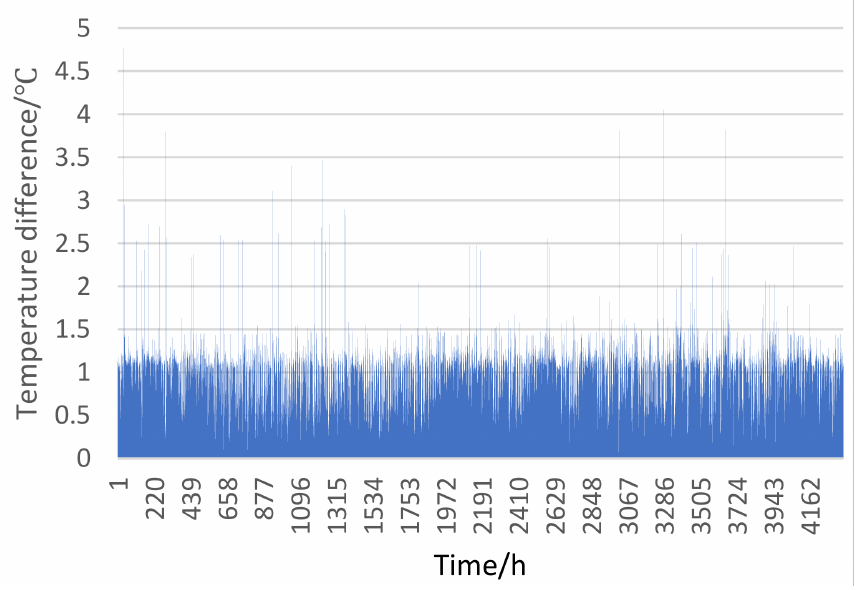
Figure 7. Temperature difference between bus capacitance and ambient